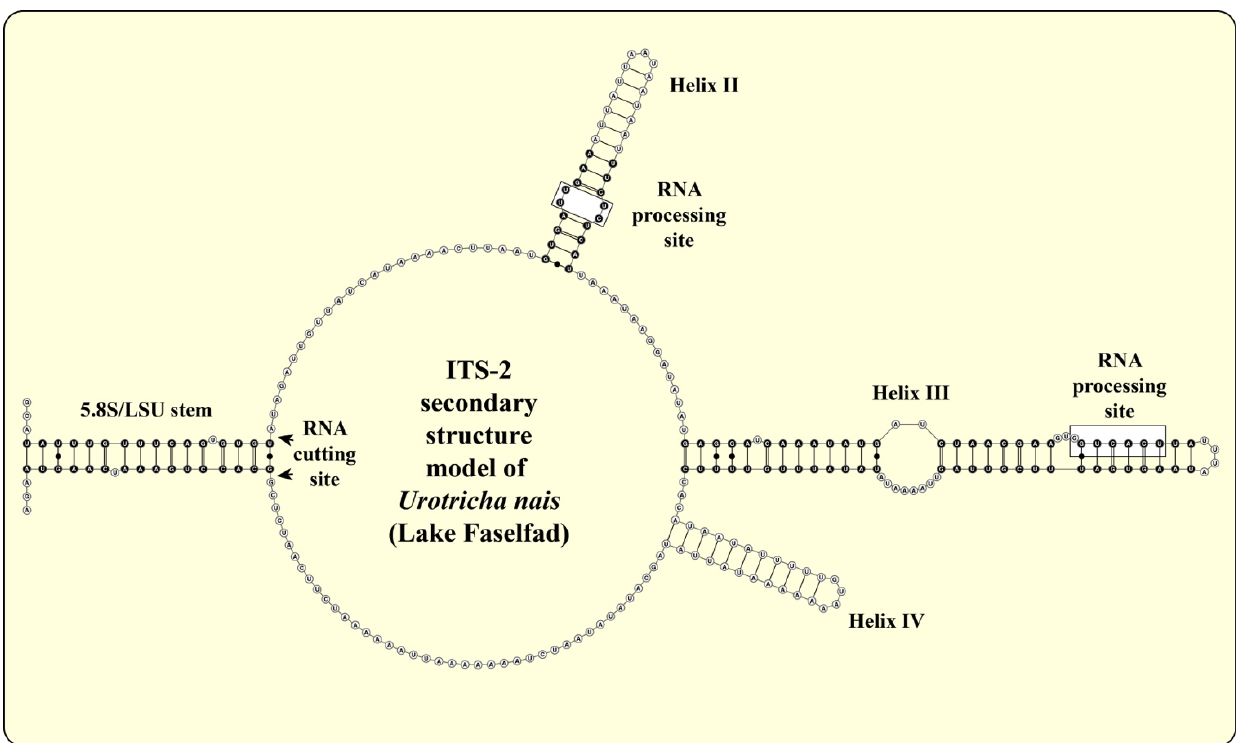
Figure 6. ITS-2 secondary structure of Urotricha nais . Bases marked in black circles were used for the ITS-2/CBC approach. The RNA processing sites are highlighted in white boxes.